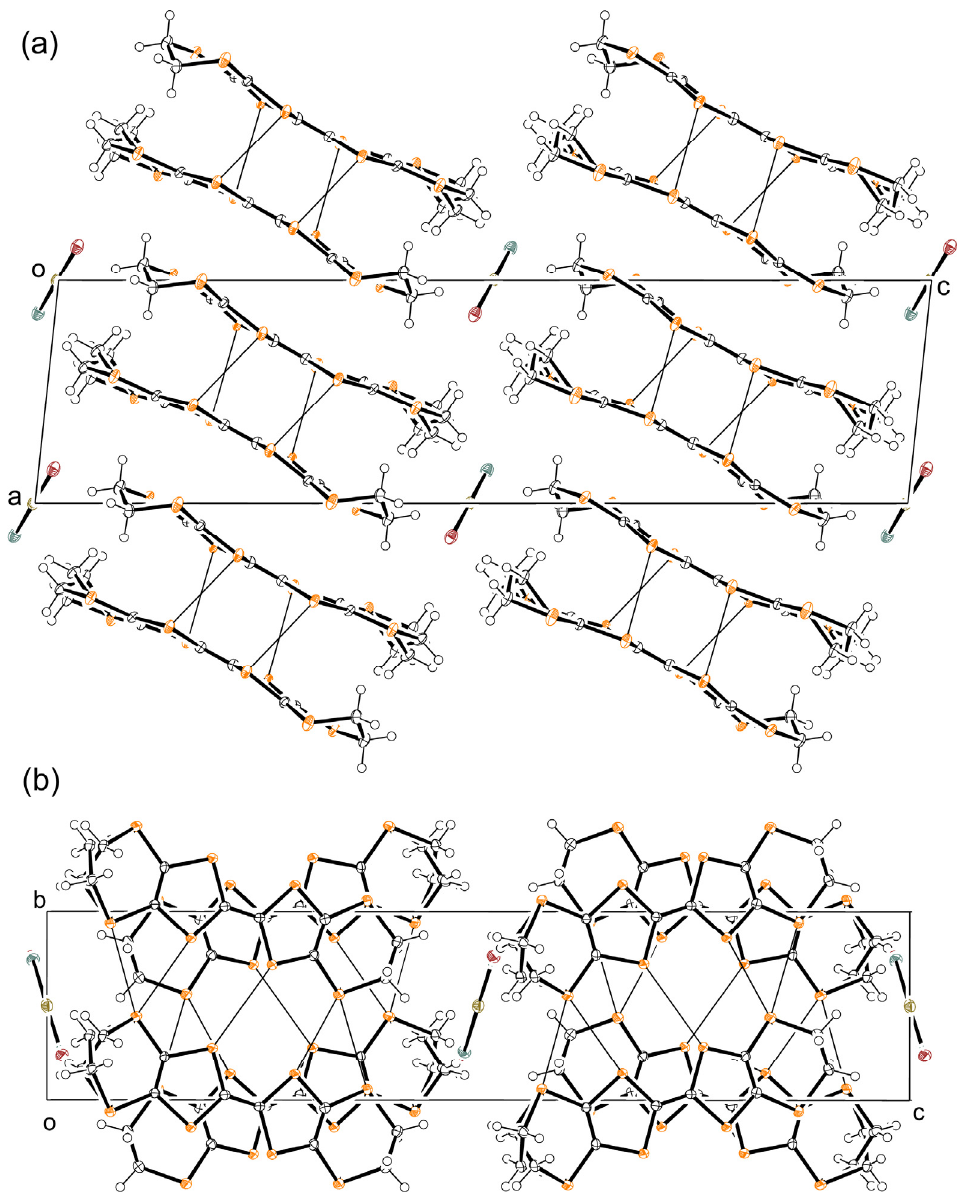
Figure 2. Packing diagrams of 1 along ( a ) b and ( b ) a